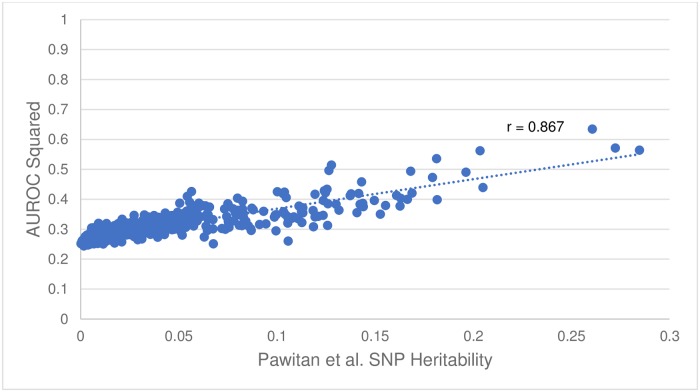
Plot of the square of the AUROC versus the Pawitan et al. [32] SNP Heritability.Correlation coefficient, r = 0.867.